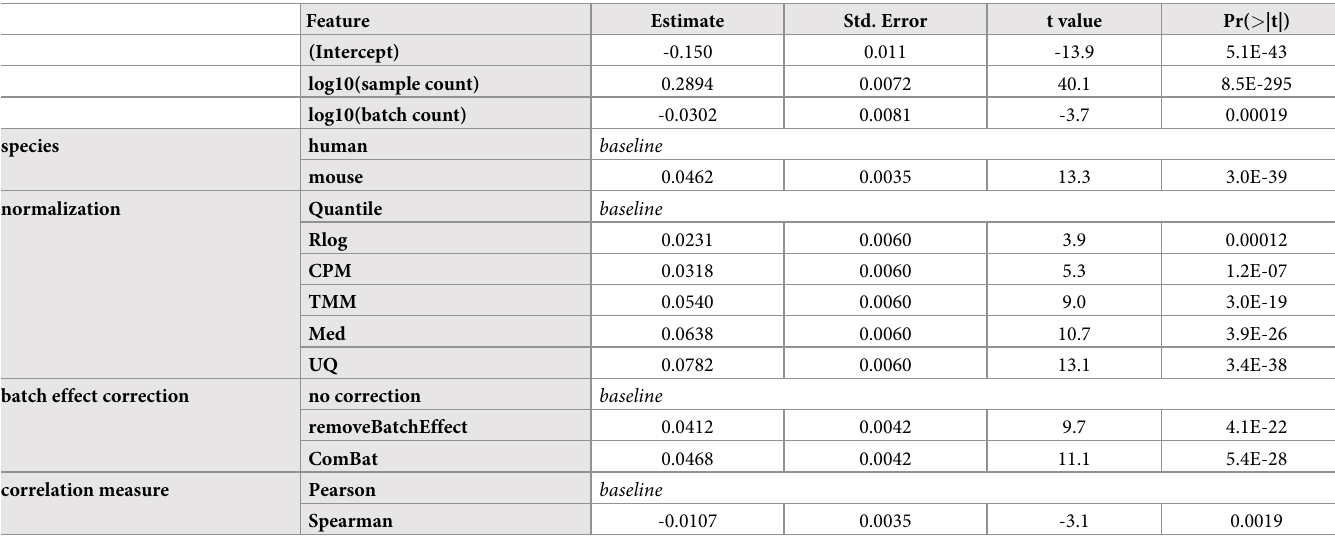
Table 2. Linear regression analysis of co-expression network quality